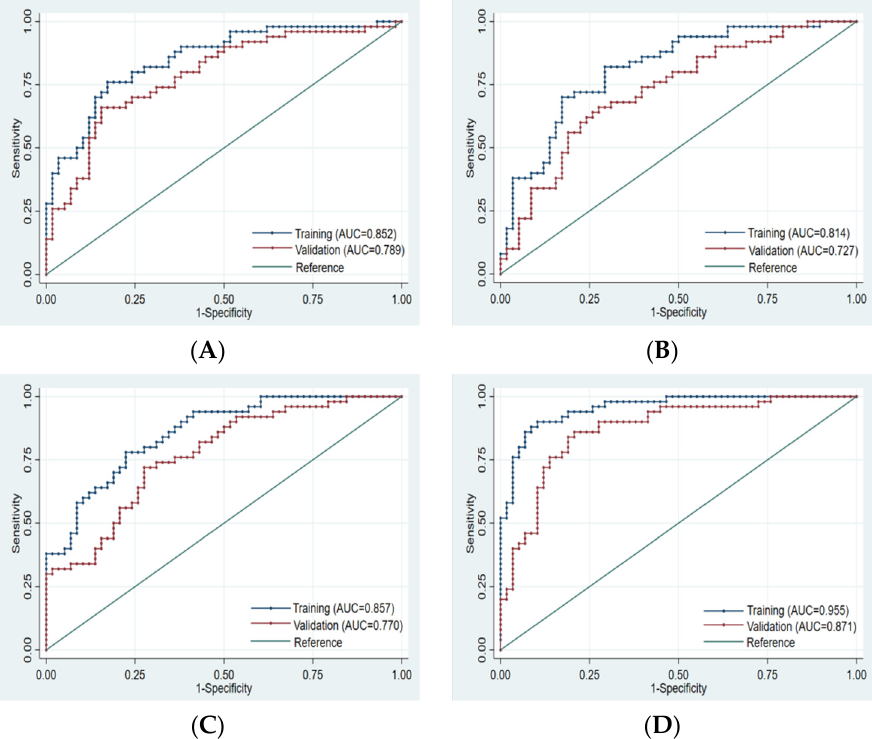
Figure 4. ROC curve of training set and validation set for each model. ( A ): FS-T2WI. ( B ): Arterial phase. ( C ): Portal venous phase. ( D ): Combined sequence. The blue curve represents the training set, and the red curve represents the validation set. Table 3. Predictive performance of each model.